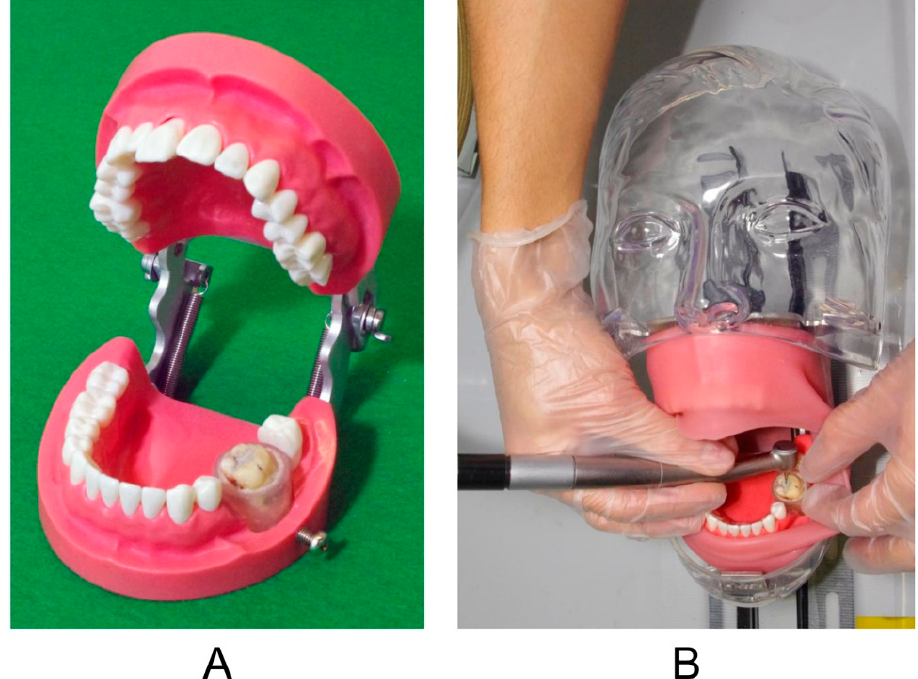
Figure 2. Tooth setting in the phantom head. ( A ) Prepared tooth placed on the left first molar posi- tion, ( B ) entire image of the phantom head with the prepared tooth.